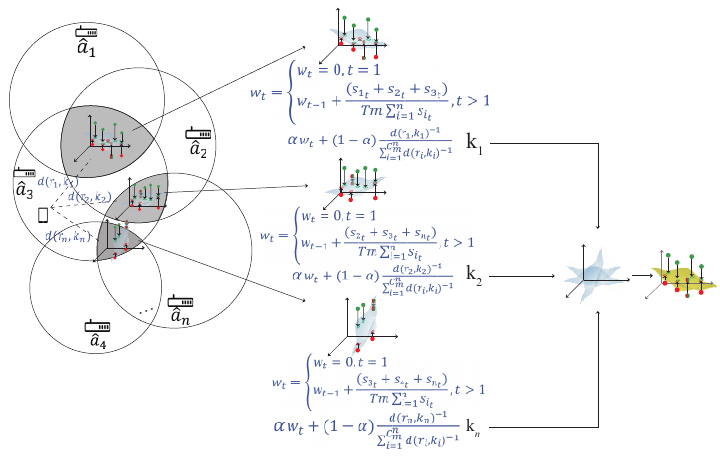
Figure 9. The weight adjustment